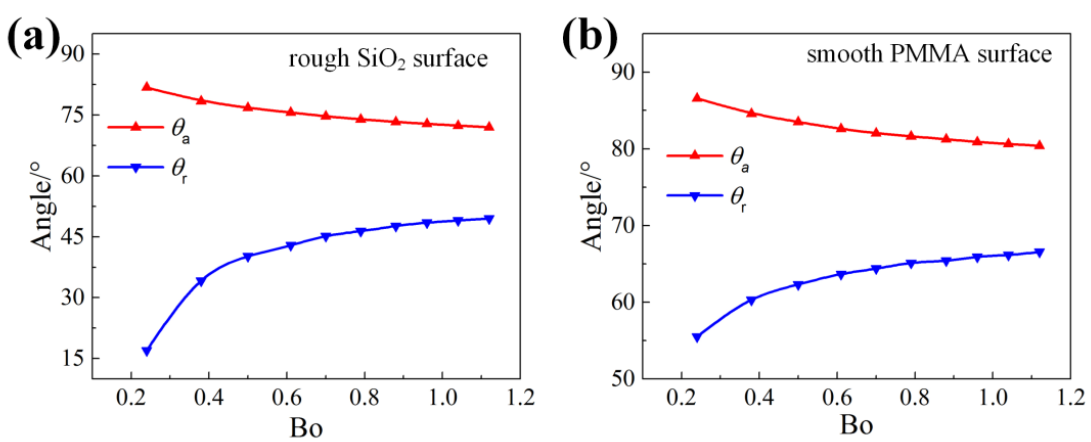
Figure 9. The relationship between the advancing/receding angle ( θ a / θ r ) and the droplet bond number. ( a ) The SiO 2 rough surface with the microstructures ( d = 6 µ m, h = 12 µ m, and a = 60 µ m). ( b ) The smooth PMMA surface.